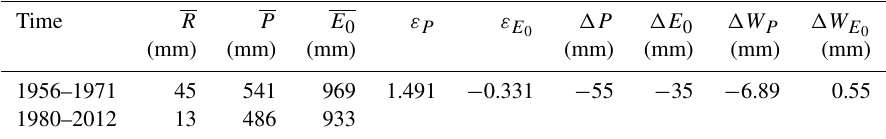
Table 2. Calculation results of impacts of climate change on inlet runoff in Fenhe River Basin.